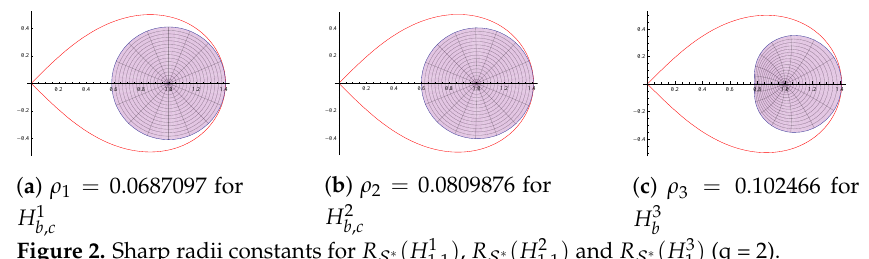
Figure 2. Sharp radii constants for R S ∗